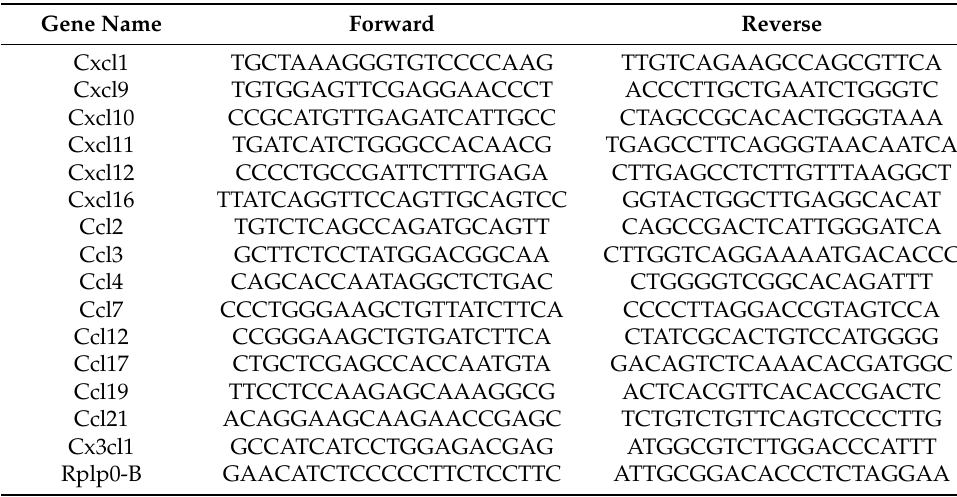
Table 1. List of rats primers used in this